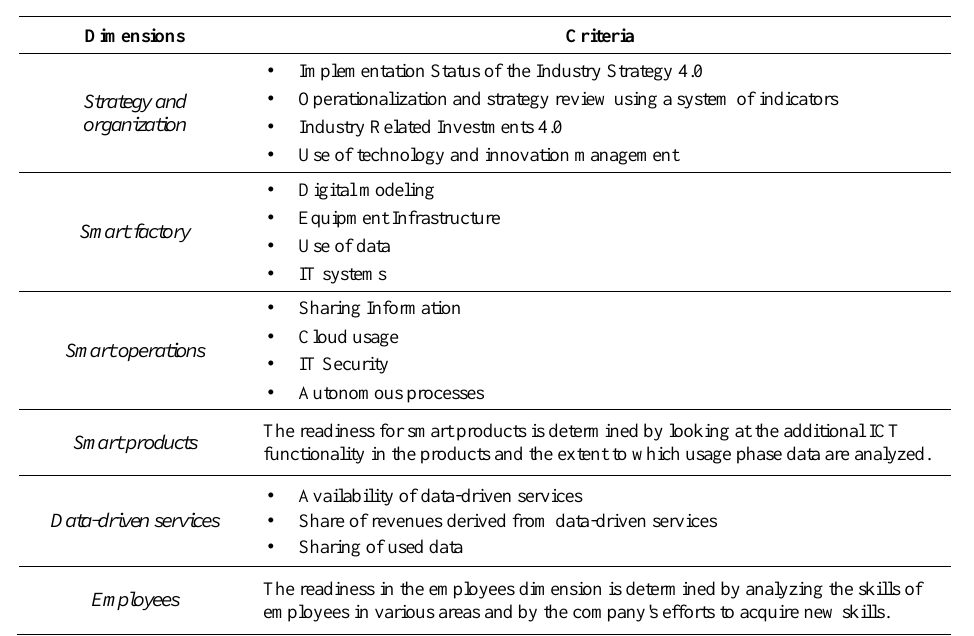
Table 1. Dimensions and criteria of the maturity model evaluation in Industry 4.0 of the VDMA [7].